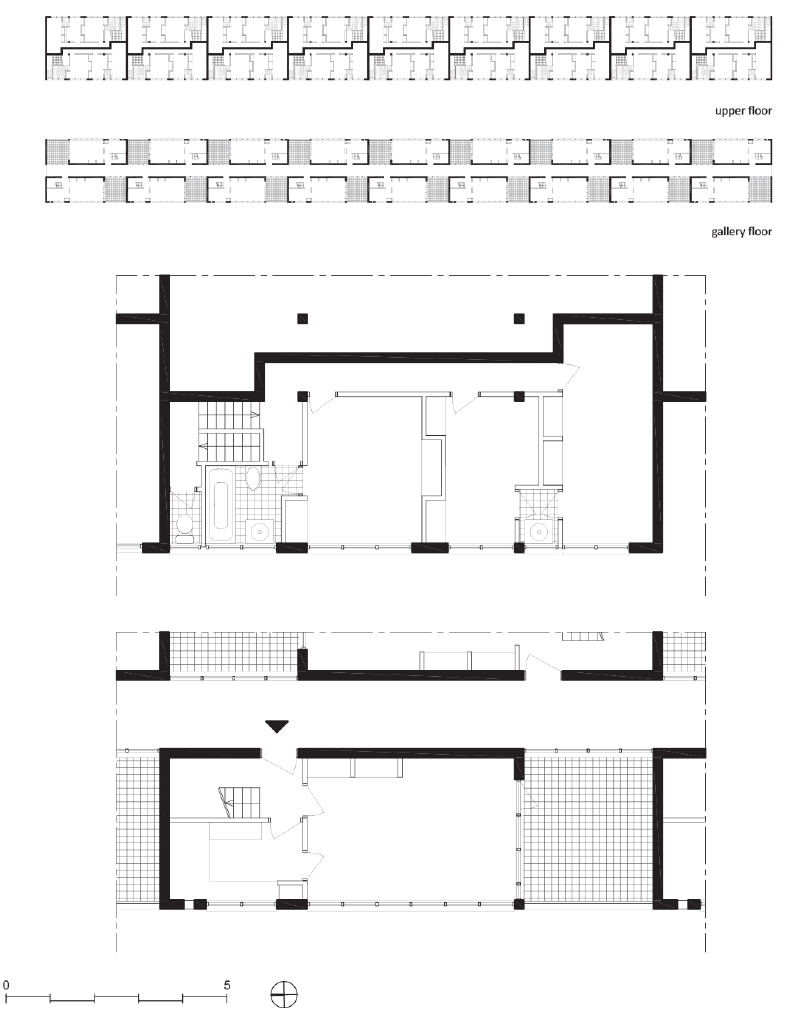
Figure 5. Bourgeois, Le Nouveau Bruxelles , 1930 (drawings by the